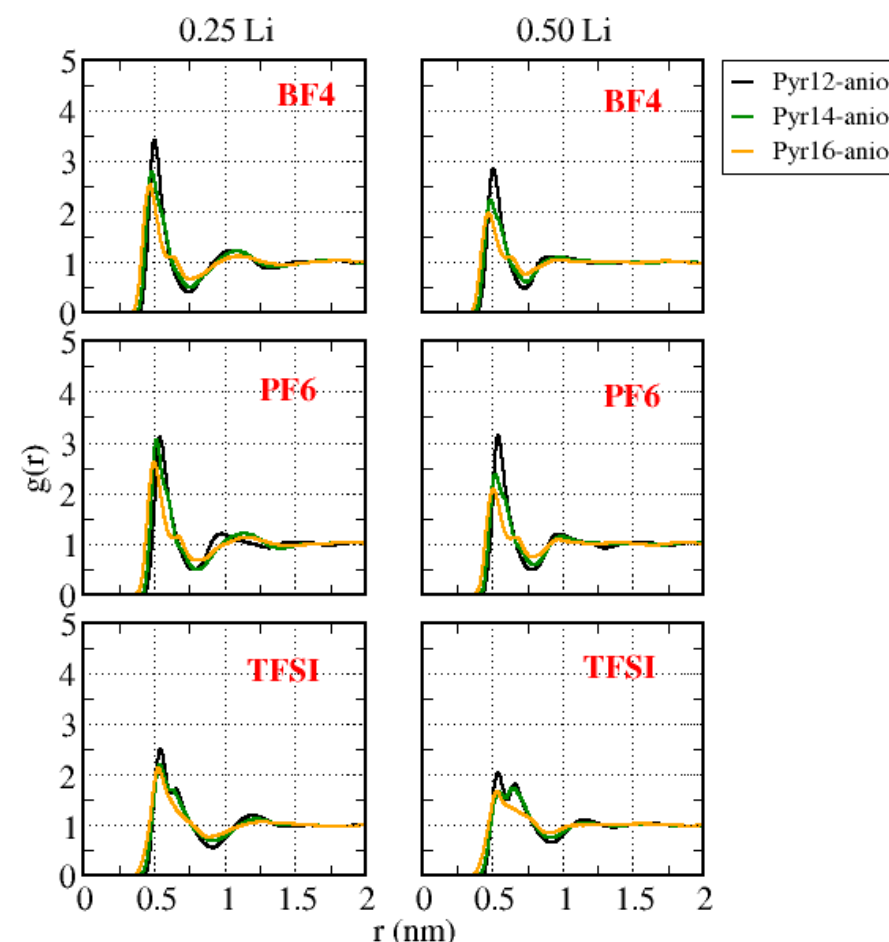
Figure 9. Center-of-mass cation–anion g ( r ) for all the systems with different amounts of